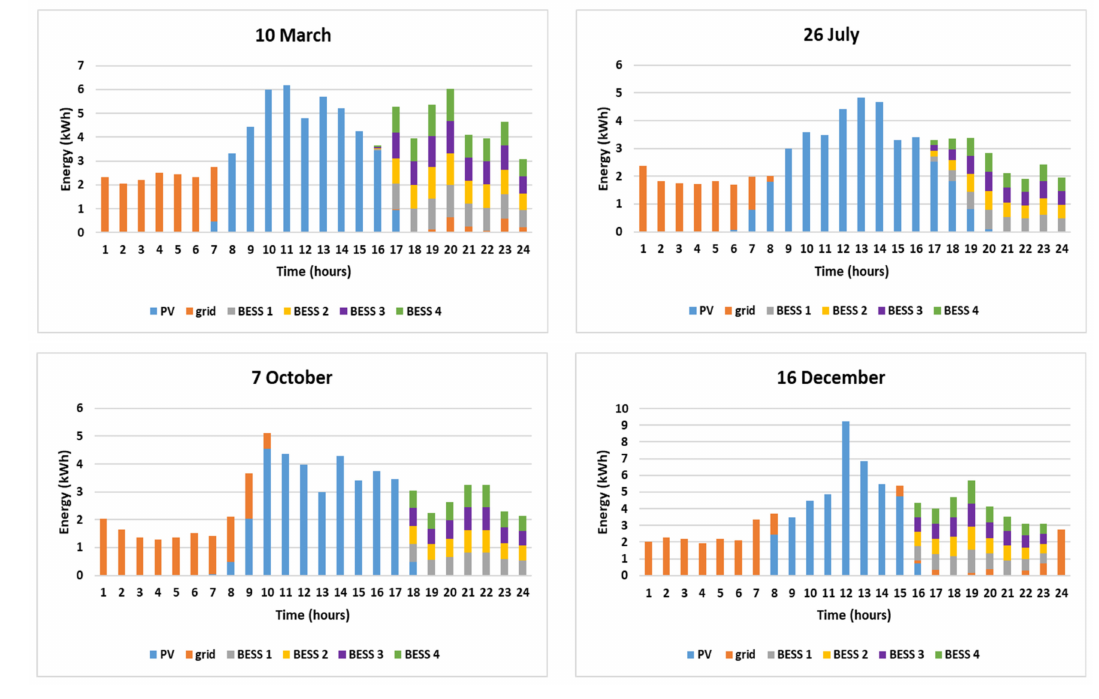
Figure 9. Energy mix of each simulated day for scenario B. Table 8. Total energy provided by one BESS for scenario